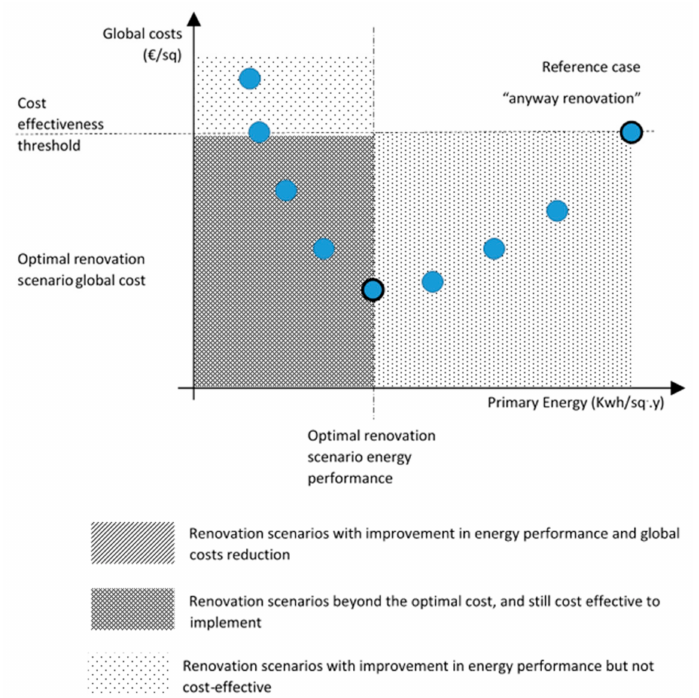
Figure 3. Demonstration of the cost optimal calculations according to the methodology. Source: Adapted from